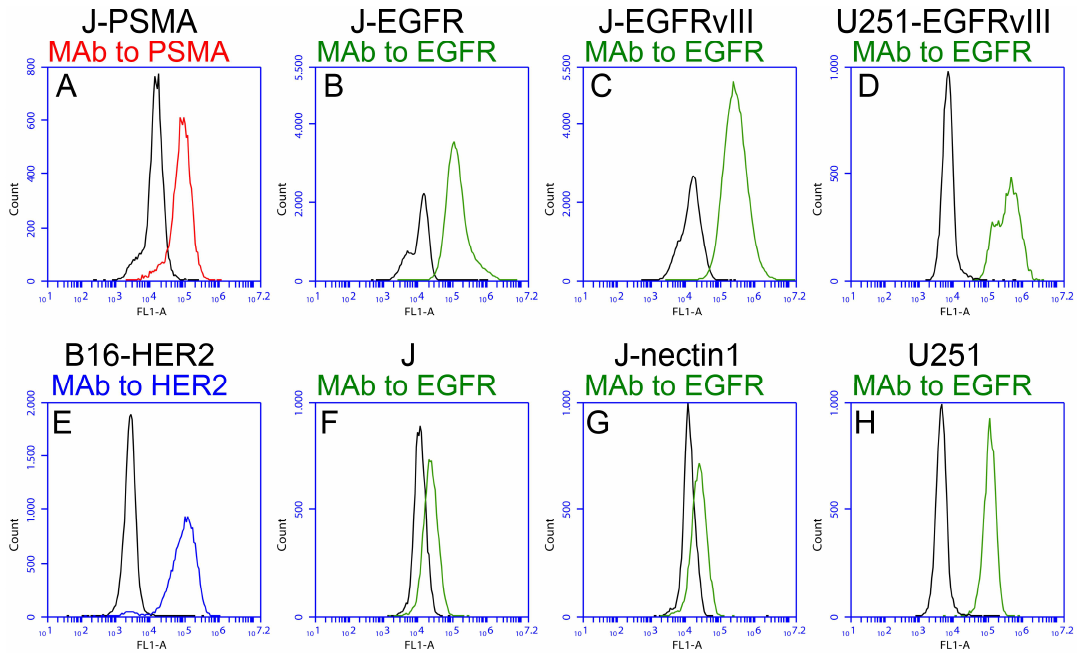
Figure 1. Expression of the indicated receptors in the cell lines generated and employed in this study. Already available cell lines are included for comparison. Cells were reacted with monoclonal antibodies to PSMA ( A , red line), EGFR ( B – H , green line), or HER2 ( E , blue line). MAb to EGFR is reactive to both EGFR and EGFRvIII. Black lines represent the background signal of the secondary antibody alone.